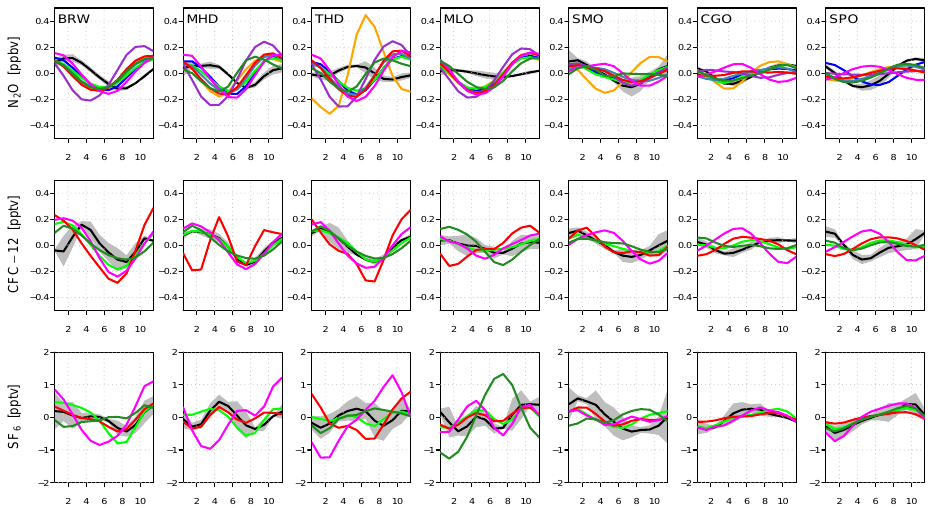
Fig. 8. Comparison of the climatological seasonal cycles (2006–2009) of N 2 O (top row), CFC-12 (middle row) and SF 6 (bottom row) for selected background stations (each column). Legend: Mozart4, yellow; ACTMt42l32, blue; ACTMt42l67, green; TM5, grey-blue; TM3- NCEP, purple; TM3-ERA, red; LMDZ4, magenta; TOMCAT, dark green; observed,